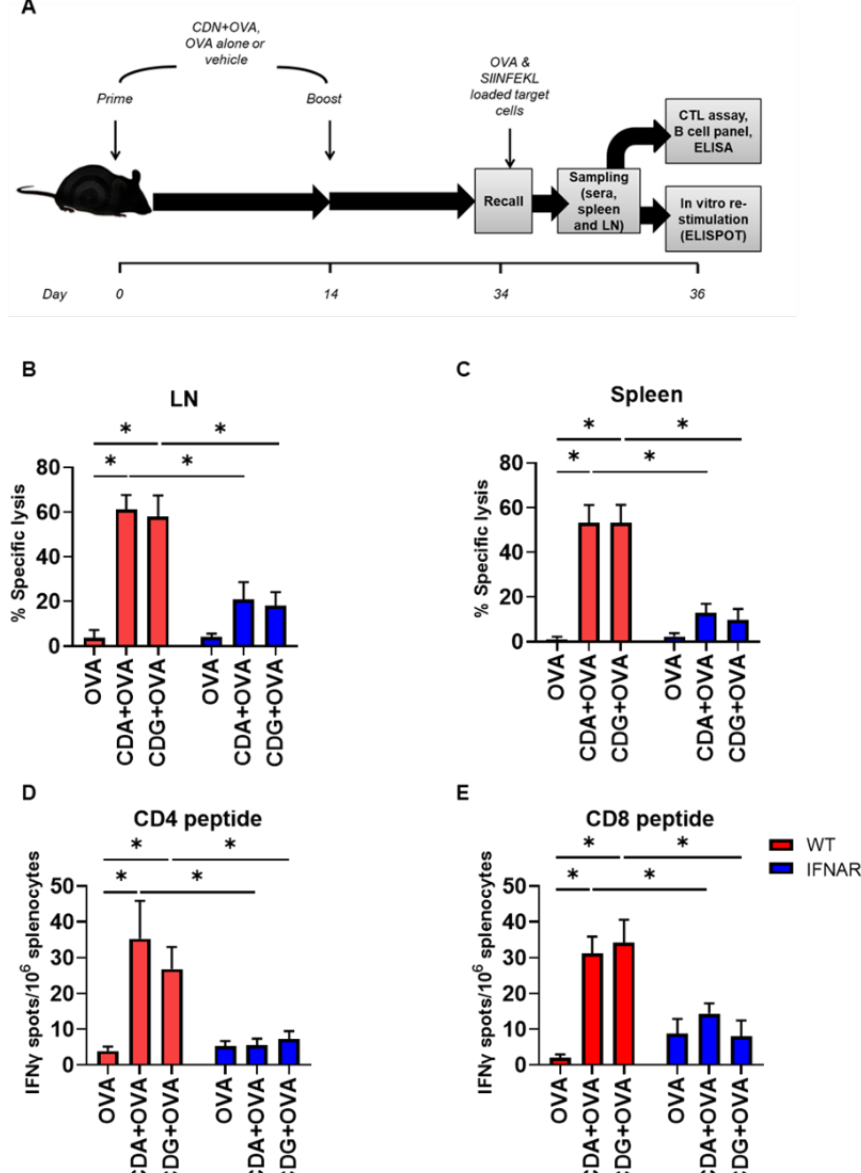
Figure 5. Type I IFN is necessary for CDN-mediated OVA-specific CTL generation in vivo. ( A ) CTL capacity to lyse SIINFEKL-pulsed target cells was assessed in vivo in vaccinated WT and IFNAR1 − / − mice. The bar graphs show the frequency of SIINFEKL-specific lysis measured in the ( B ) inguinal lymph nodes and ( C ) spleen of vaccinated mice. IFN γ -secreting splenocytes were quantified in the presence of ( D ) the CD4 peptide and ( E ) the CD8 peptide. Error bars indicate SEM. Statistical significance was calculated using a one-tailed Student’s t -test. * indicates p < 0.05. Data shown are from two independent experiments (WT, n = 7– 8; IFNAR1−/−, n = 6 –9).